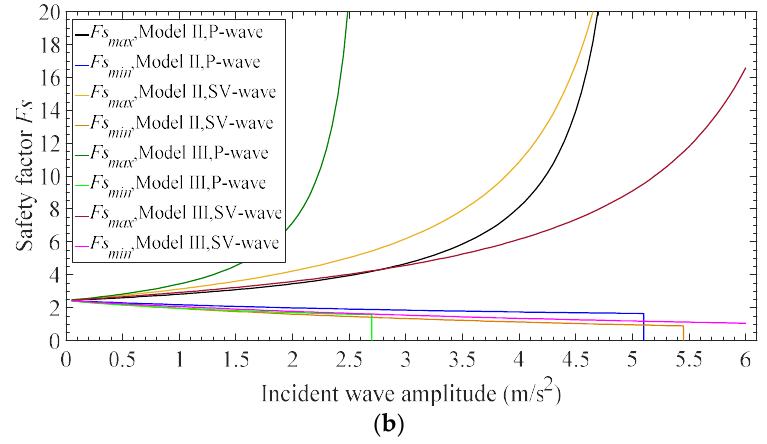
Figure 7. Instantaneous safety factor vs. wave’s amplitude: ( a ) comparison between models I and II; ( b ) comparison between models II and III.